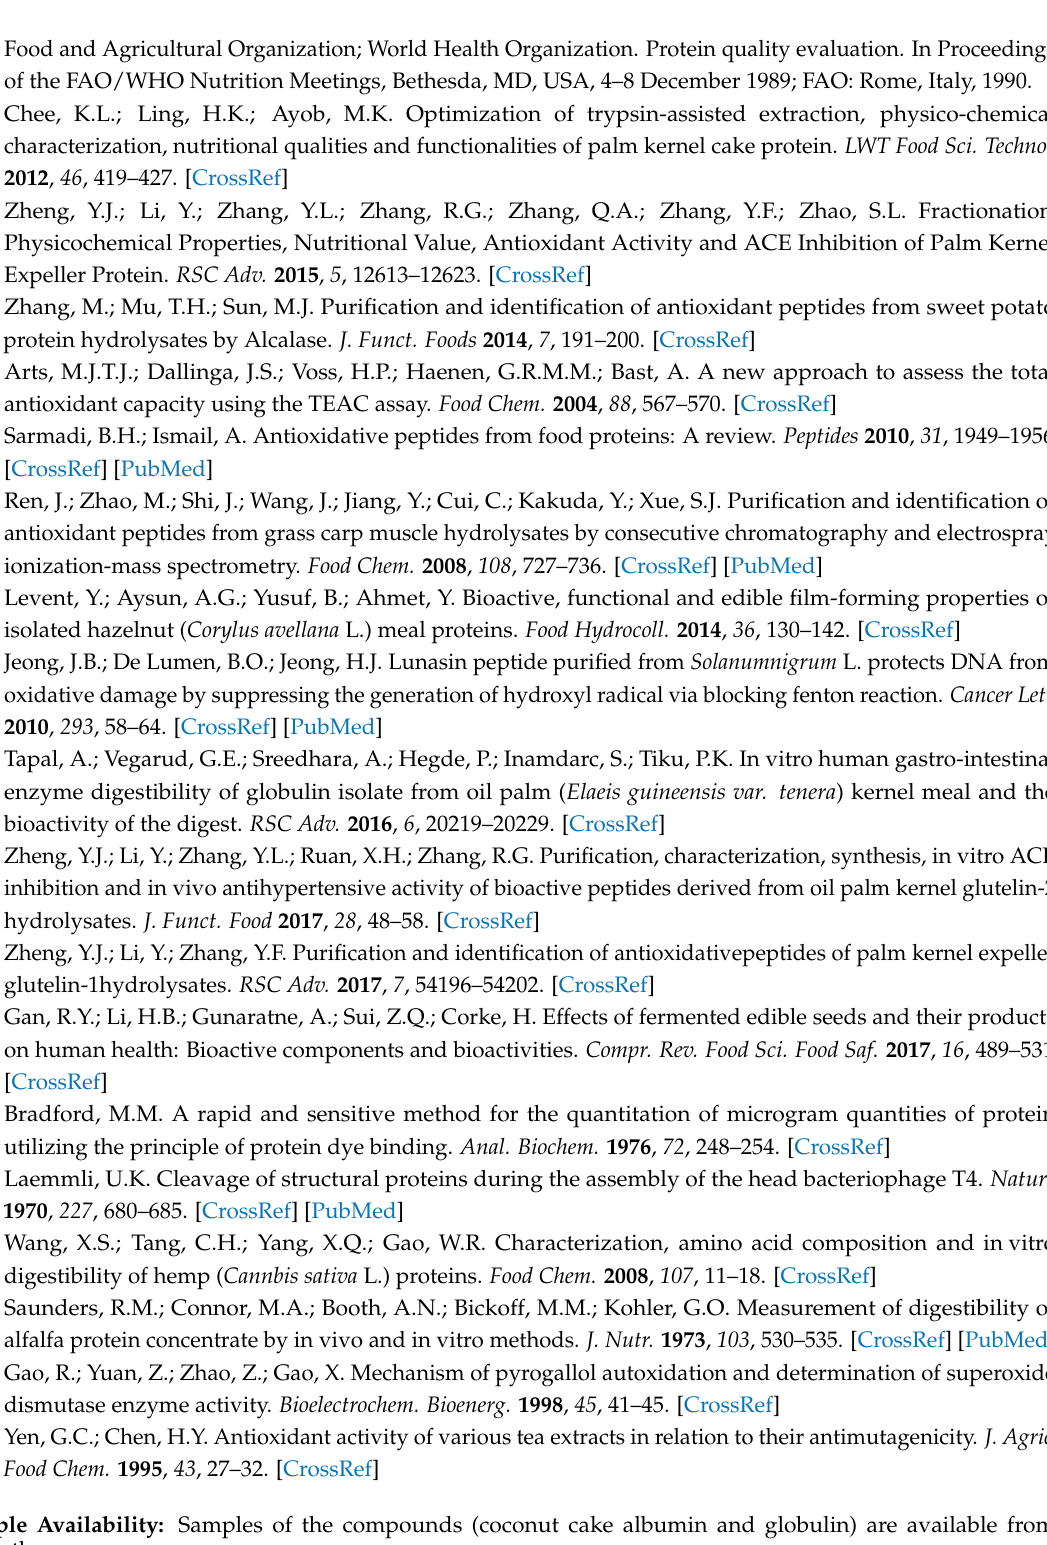
Sample Availability: Samples of the compounds (coconut cake albumin and globulin) are available from the